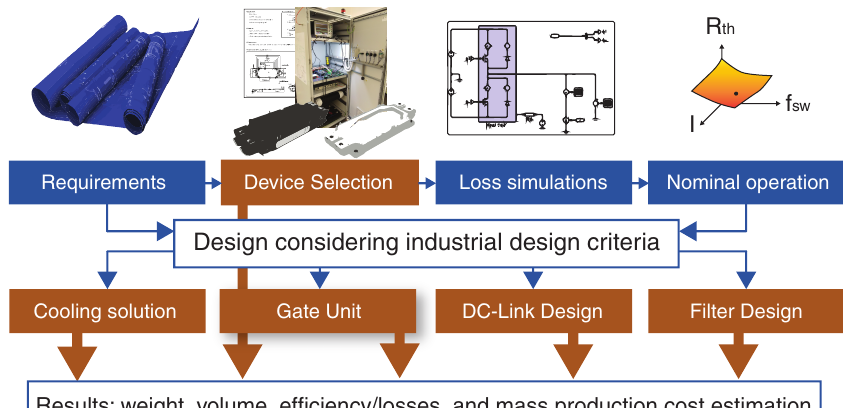
Figure 3. Summary of the employed methodology used in this study to perform the converter designs and its corresponding